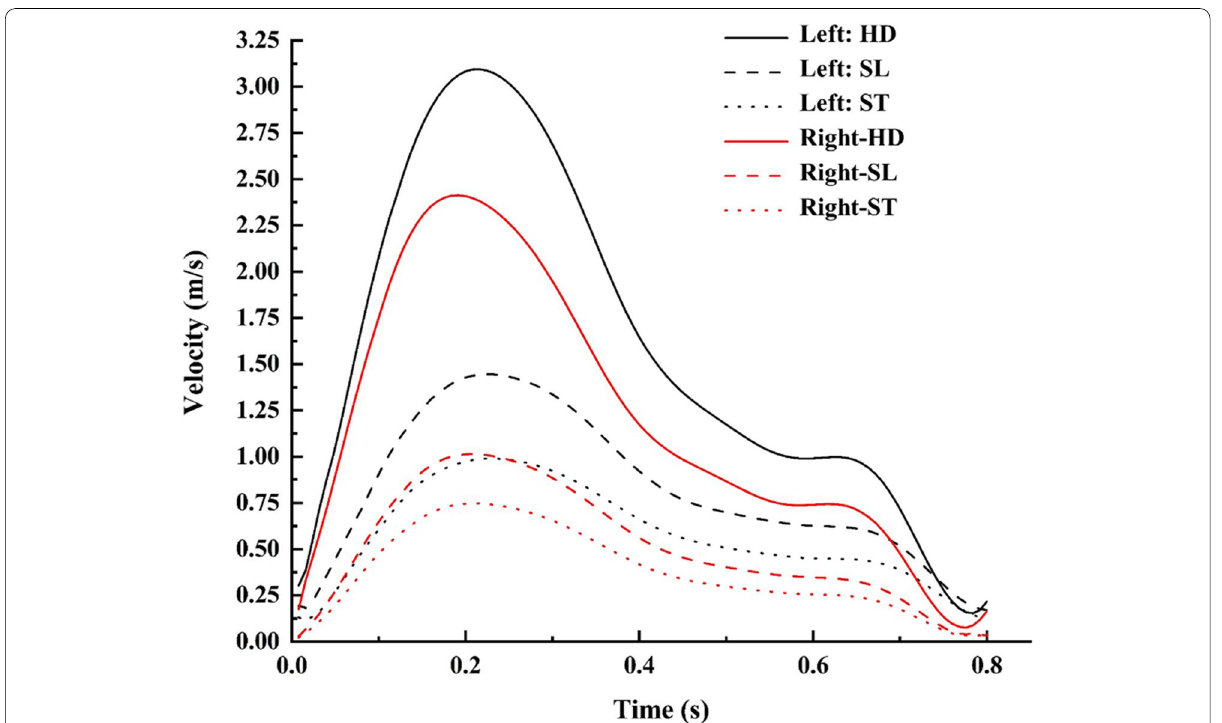
Fig. 7 Maximum velocity comparison for various